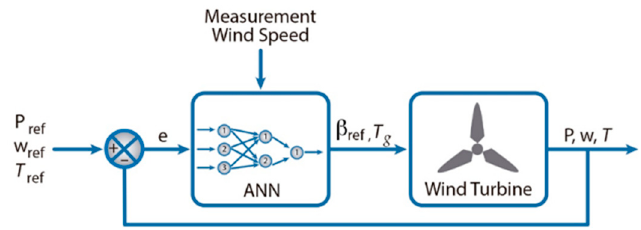
Figure 17. Individual pitch controller based on a neural network of radial base function (RBFNN) model, which measures wind speed with light detection and range (LIDAR) [75].